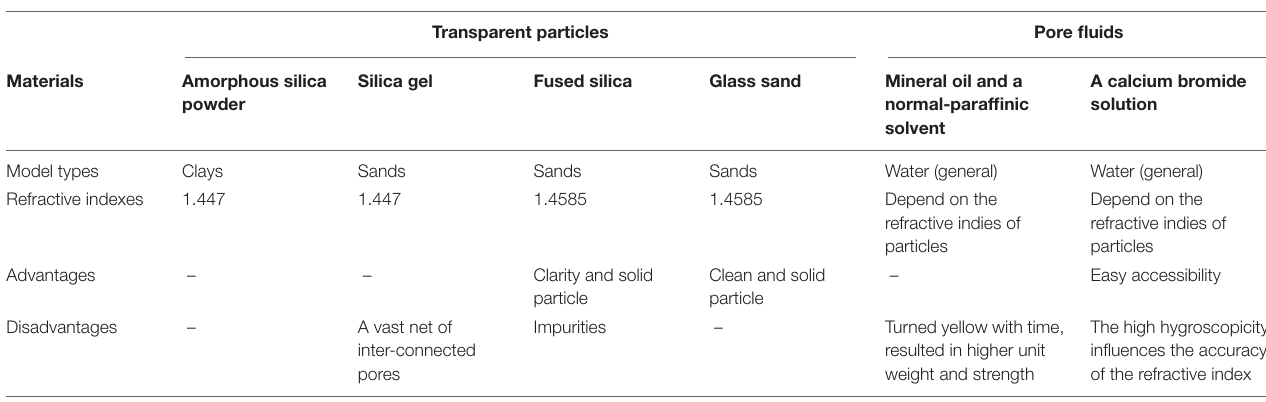
TABLE 1 | Summary of transparent